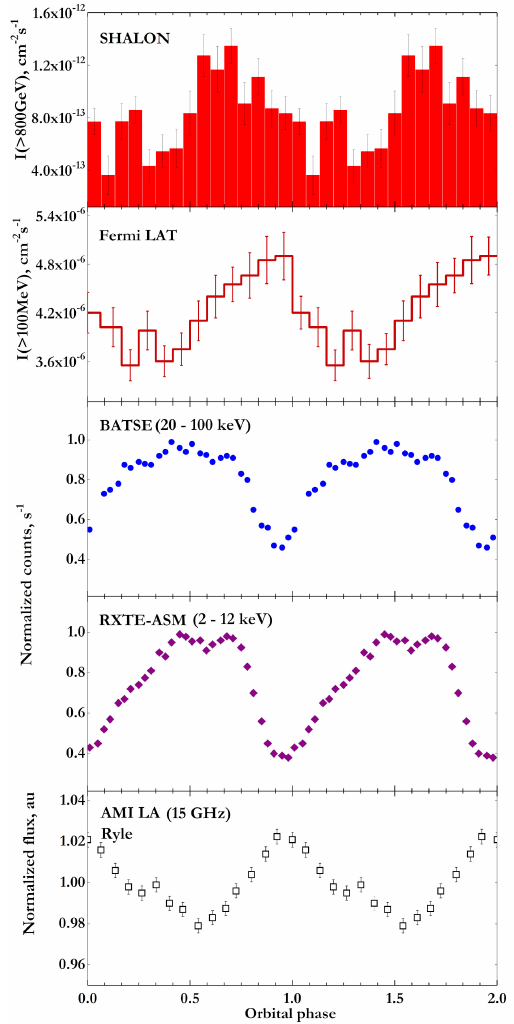
Figure 4. The light curve of Cyg X-3 folded with the orbital period of 4.8 h by SHALON (red area) compared with other data (see